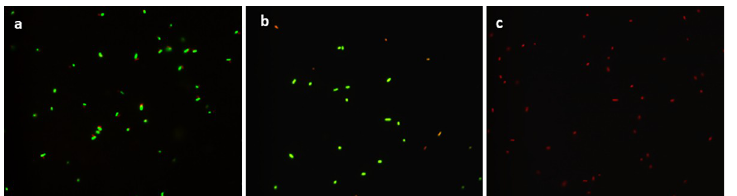
Fig 2. Electron beam-inactivated ST (EBST) maintains cell membrane integrity. Membrane integrity of S . Typhimurium remains unaffected by eBeam irradiation. Staining with Live/ Dead BacLight kit reveals the presence of intact cell membrane for (A) Live ST and (B) EBST indicated by the green labelled bacterial cells. Red colored staining of (C) HKST indicates disrupted cell membrane due to heat treatment.